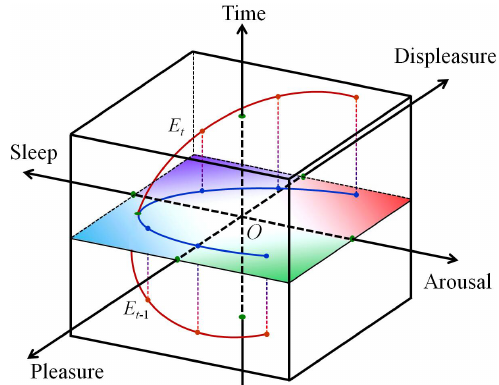
Figure 5. Graphical description of QES based on the QPA plane in Figure